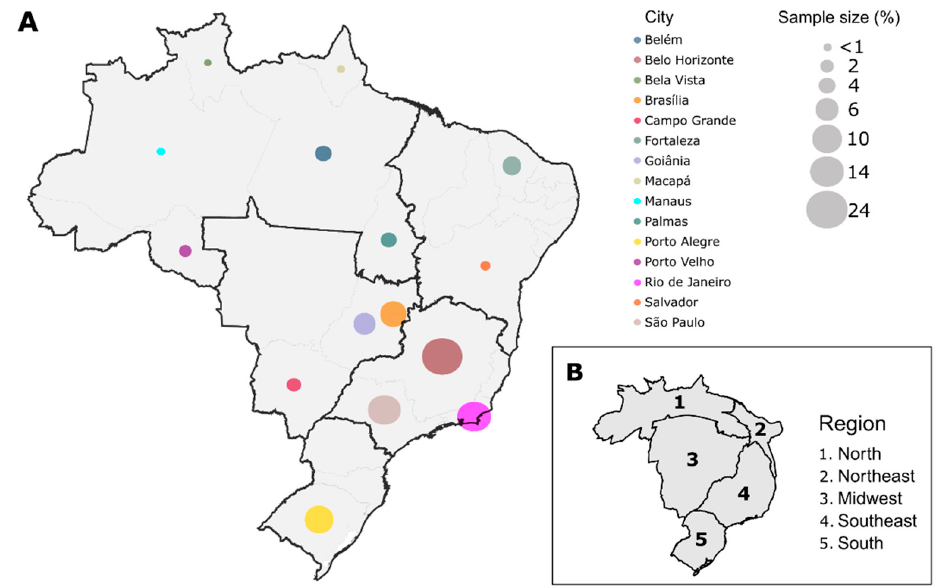
Figure 1. Schematic representation of study sampling. ( A ) Samples from 15 different capitals of Brazil, representing the five regions (North, Northeast, Midwest, Southeast, and South) were included in our study. In total, 7549 samples were analyzed and the proportion of samples for each capital is represented by the size of the colored circles. Each color represents a different capital; ( B ) Cartogram of the sampling representativeness according to the population size of each Brazilian region.